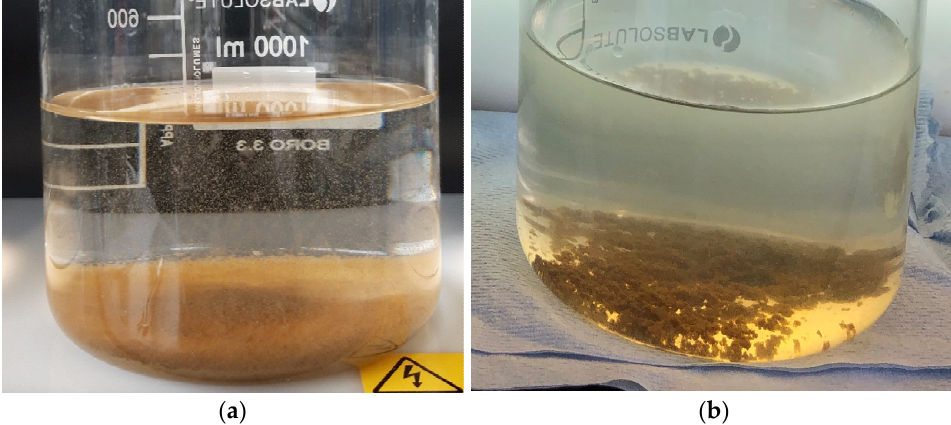
Figure 4. Beakers with flocculating sludge of 100% Moringa flocculant ( a ) and 100% cactus flocculant ( b ) in surface water.